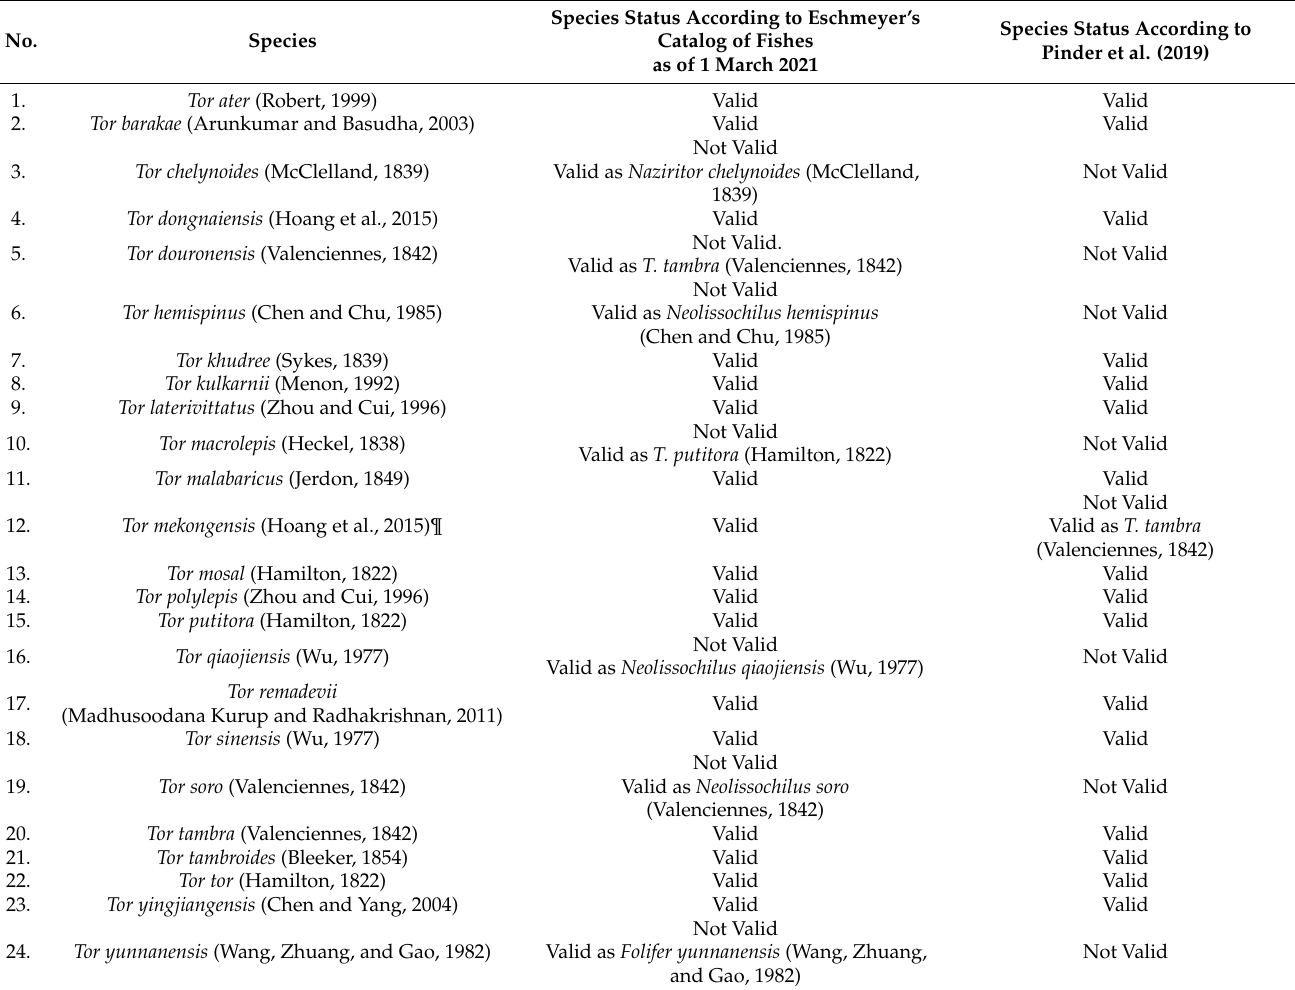
Table 1. List of reported Tor species worldwide and their validity from two different sources: Eschmeyer’s Catalog of Fishes and Pinder et al.